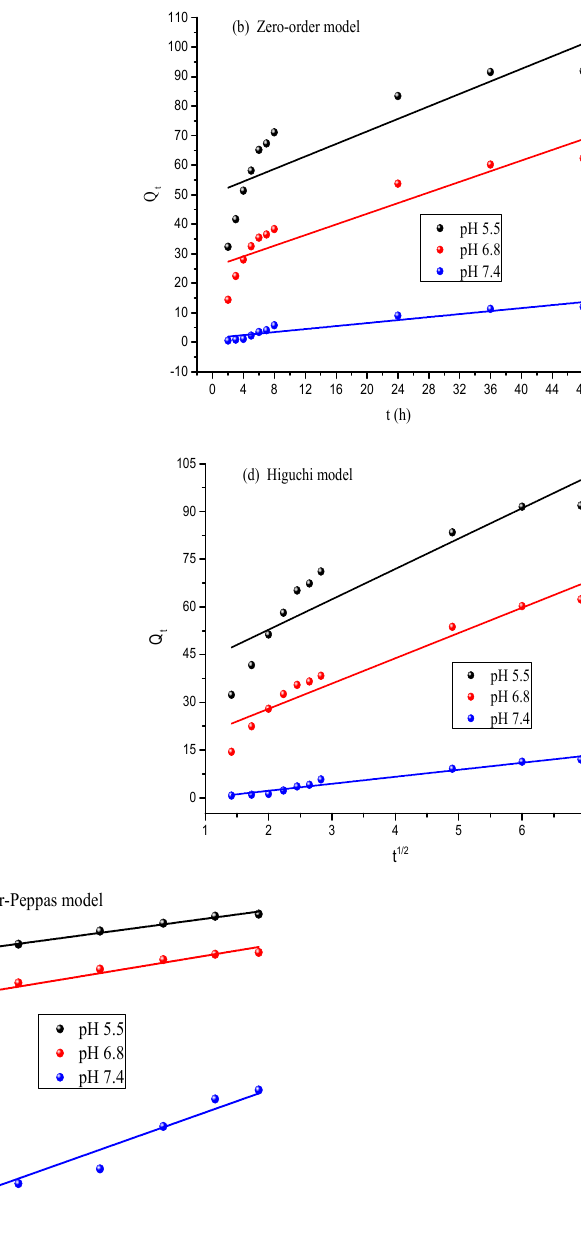
Figure 8. %Release (P r ) of DOX with time ( a ); drug release kinetic plots for DOX release from the DOX–MOGN under different pH conditions release: ( b ) zero–order, ( c ) first–order, ( d ) Higuchi and ( e ) Korsmeyer–Peppas plot. Table 2. Release parameters of different kinetic models for DOX at different pHs.